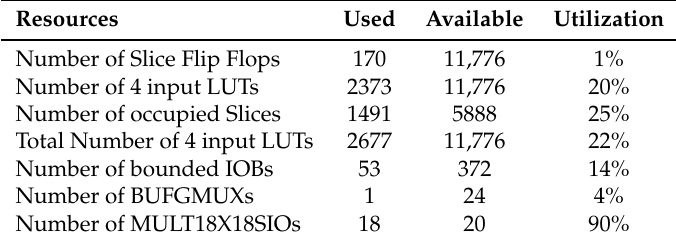
Table 2. FPGA utilization summary for the uncontrolled Lorenz slave system.